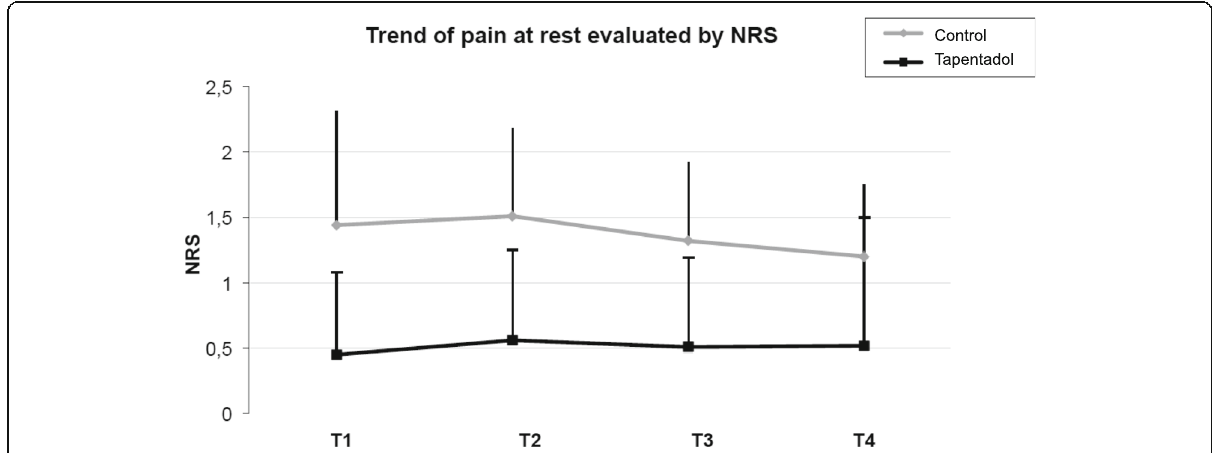
Fig. 1 Trend of pain at rest evaluated by NRS in both treatment groups (Grey: Control group; Black: Tapentadol)